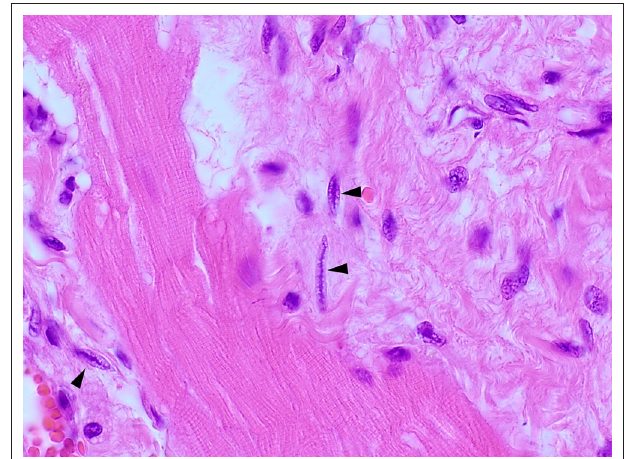
FIGURE 8 | Heart, Eurasian lynx ( Lynx lynx carpathicus ), H&E stain: Multiple Anitschkow cells with their characteristic chromatin arrangement (black